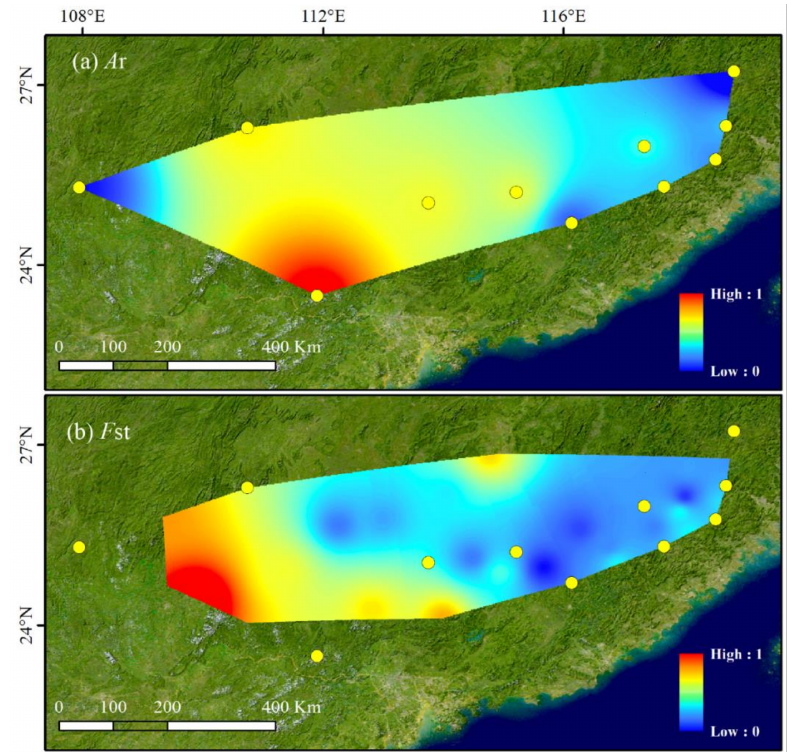
Figure 4. Spatial interpolation of genetic diversity ( a ) and genetic di ff erentiation ( b ) of Quercus